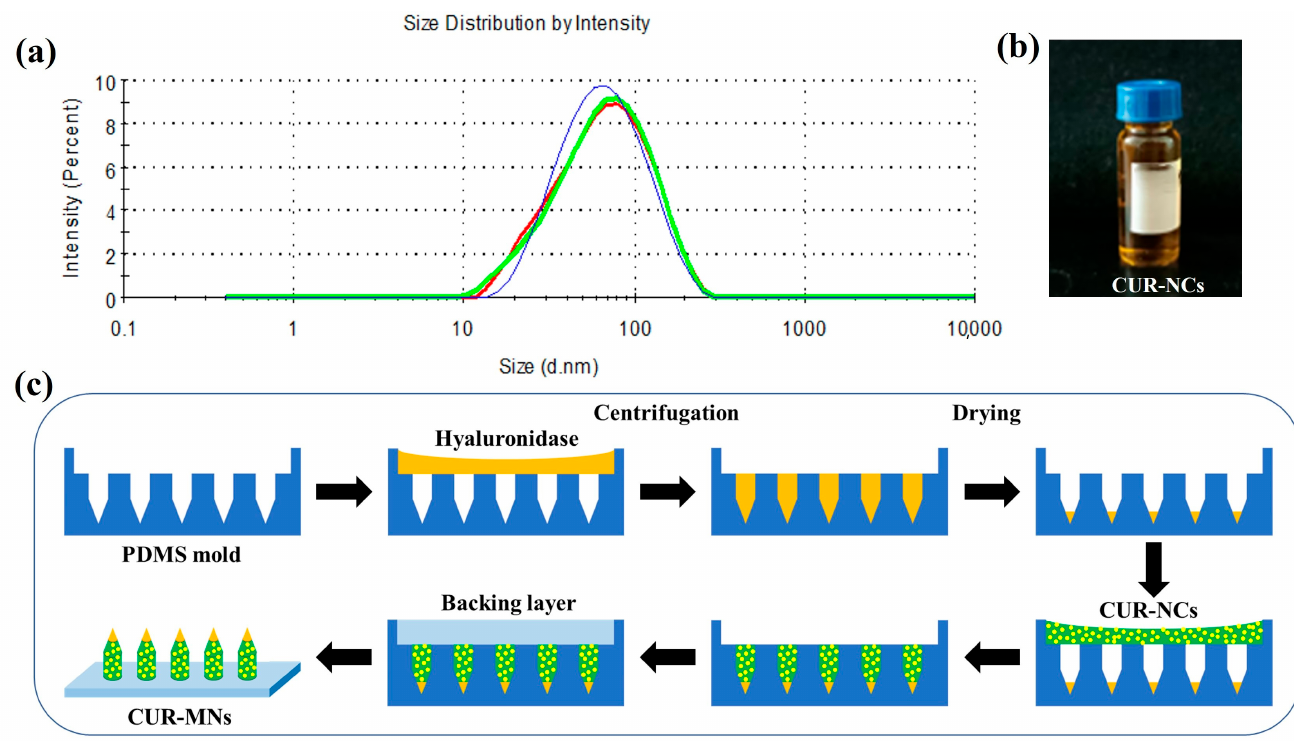
Figure 1. ( a ) The particle-size distribution by intensity of CUR-NCs (The blue, green, and red color curves represent the results of three tests of the same sample, respectively); ( b ) The nanosuspension of 55 nm-size CUR-NCs; ( c ) Fabrication process of CUR-MNs.